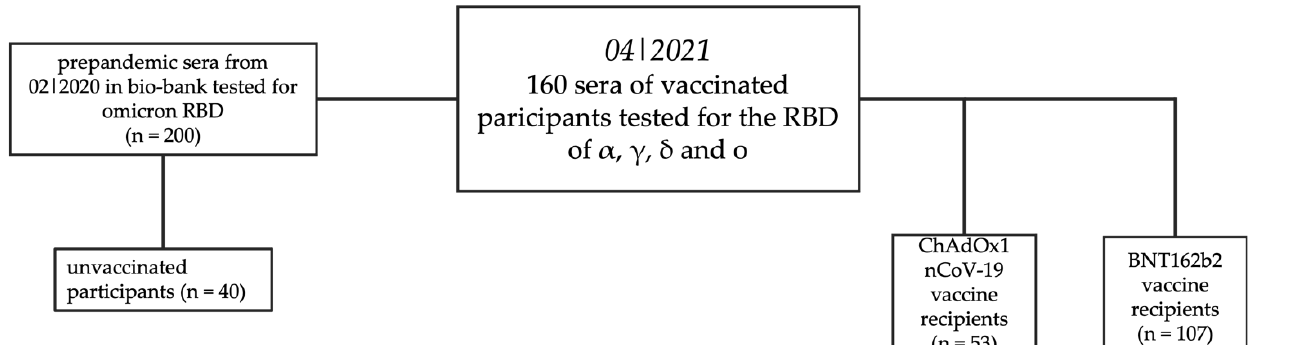
Figure 1. Flow chart of analyzed sera and vaccination status.